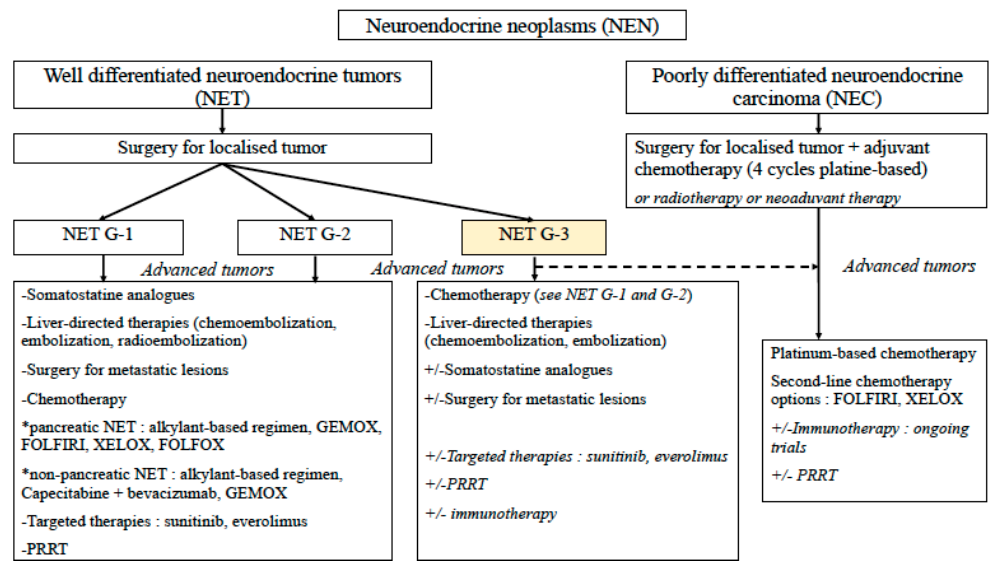
Figure 2. Proposed algorithm for therapeutic management of NET G − 3 of the digestive tract. G − 1: grade 1, G − 2: grade 2, G − 3: grade 3, GEMOX: gemcitabine + oxaliplatine, FOLFIRI: 5-fluorouracile + irinotecan, FOLFOX: 5-fluorouracile + oxaliplatine, XELOX: capecitabine + oxaliplatine, PRRT: Peptide receptor radionuclide therapy.